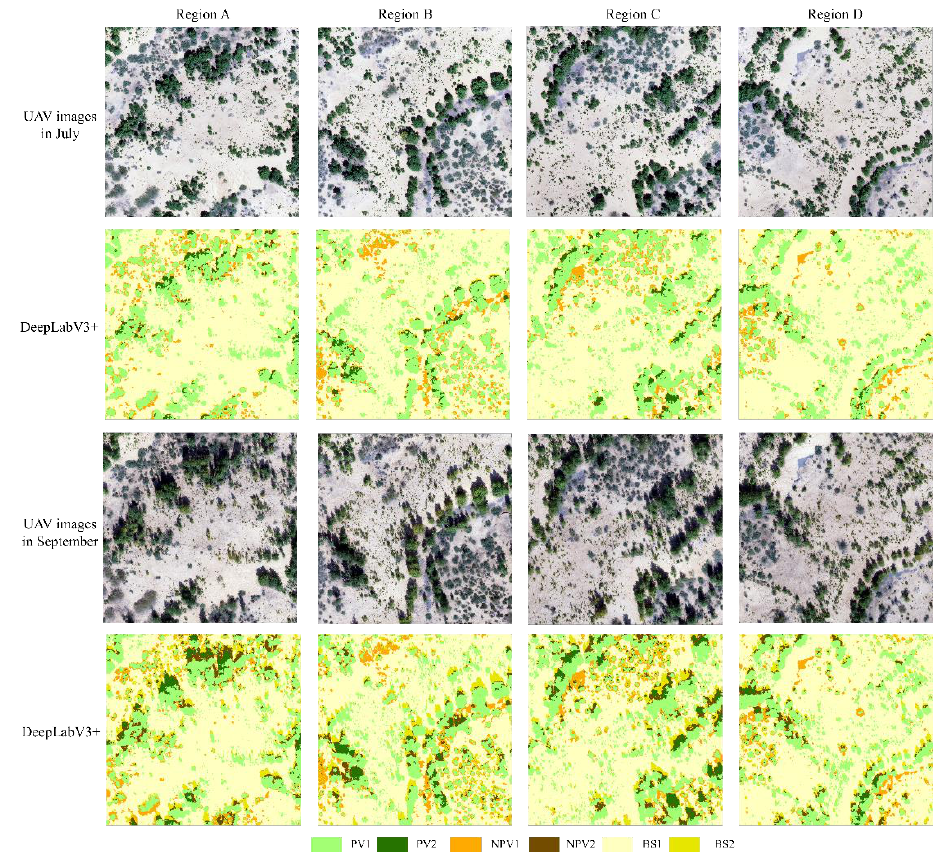
period sample areas at the same location, and (iii) different location sample areas across different periods. DeepLabV3+ proved to be suitable for the estimation of PV/NPV in desert areas.